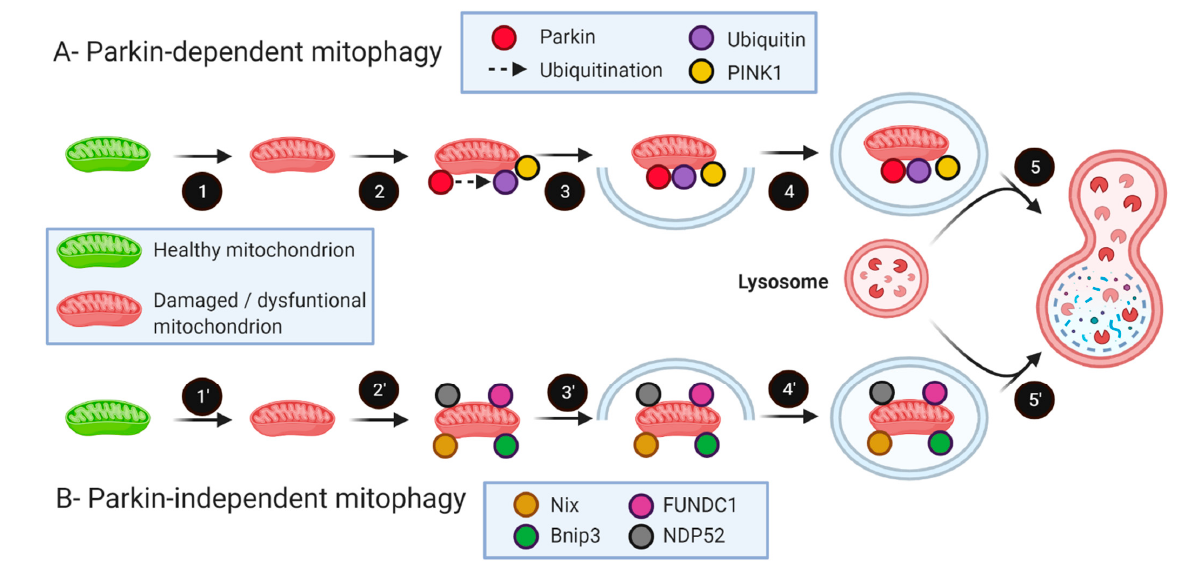
Figure 3. Parkin-dependent and Parkin-independent mitophagy pathways. ( A ) Parkin-dependent mitophagy pathway: in dysfunctional mitochondria, PINK1 stabilizes on the OMM leading to the recruitment of Parkin through a series of mod- ifications, including ubiquitination and phosphorylation of Parkin and ubiquitin. During mitophagy, Parkin polyubiqui- tinates various OMM proteins, including mitofusins (Mfn1 and Mfn2), VDAC, Tom20, and Miro. Ubiquitinated proteins are recognized by several adaptors, leading to the recruitment of an autophagosome and subsequent degradation of the mitochondrion. ( B ) Parkin-independent mitophagy pathway: mitochondrial proteins, such as Nix, Bnip3, FUNDC1, and NDP52, can act as mitophagy receptors, promoting the recruitment of the autophagosome around the cargo. Created with BioRender.com.